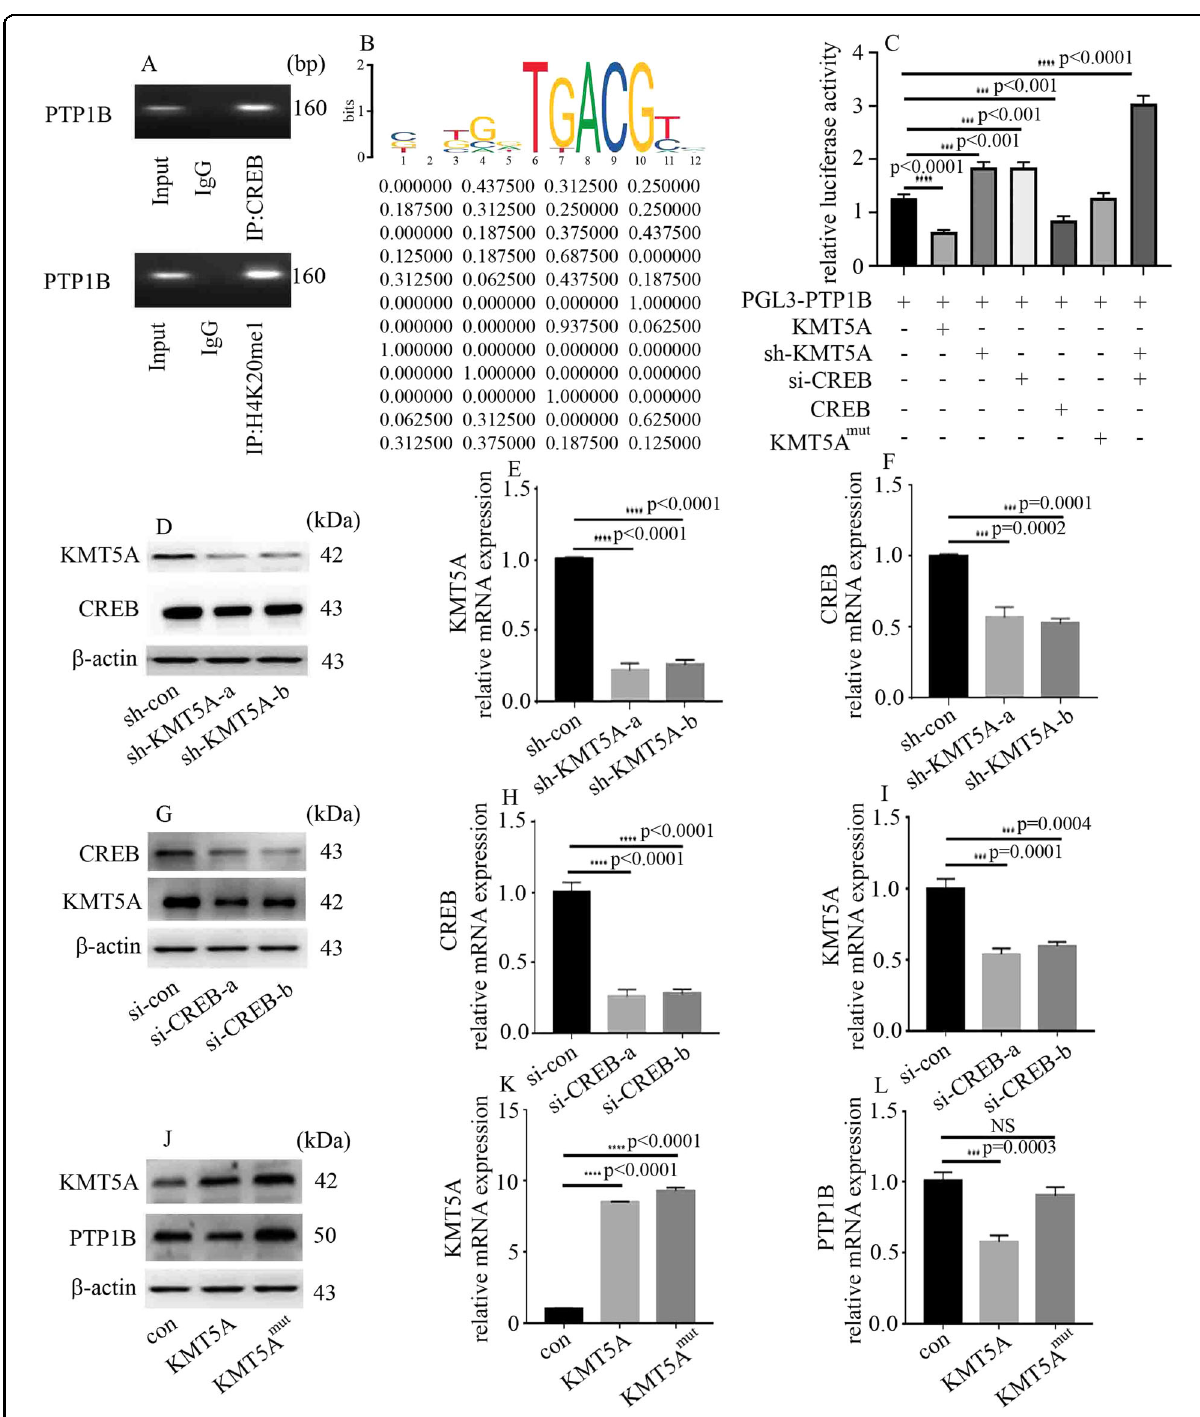
Fig. 6 CREB interacts with KMT5A to regulate PTP1B transcriptional activity in endothelial cells. A CREB and H4K20me1 were enriched at the PTP1B promoter region. B The putative CREB binding site of PTP1B. C PTP1B promoter activity was determined by luciferase reporter assays. D western blot analysis of KMT5A and CREB levels in HUVECs. E , F qPCR analysis of mRNA expression of KMT5A and CREB. G western blot analysis of KMT5A and CREB levels in HUVECs. H , I qPCR analysis of mRNA expression of KMT5A and CREB. J western blot analysis of KMT5A and PTP1B levels in HUVECs. K , L qPCR analysis of mRNA expression of KMT5A and PTP1B. (* p < 0.05, ** p < 0.01, *** p < 0.001, **** p < 0.0001, n =